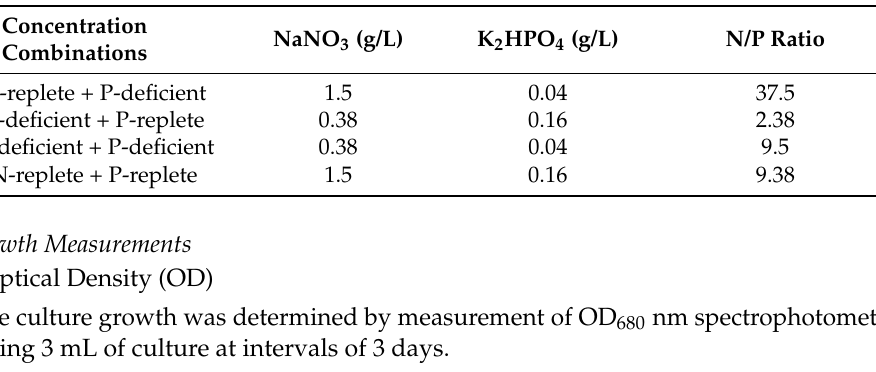
Nitrogen and phosphorus concentration combinations used in modified BG-11 cultivation